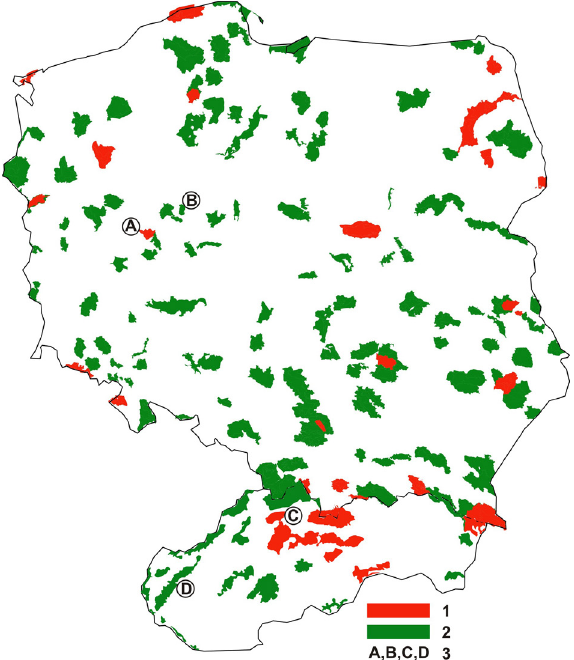
Fig. 1. National and landscape parks in Poland and Slovakia along with the location of the investigated areas: 1 – national parks; 2 – landscape parks; 3 – investigated parks: A – Wielkopolska National Park (WPN); B – Lednica Landscape Park (LPK); C – Malá Fatra National Park (NPMF); D – Little Carpathians Protected Landscape Area (CHKOMK) Source: own